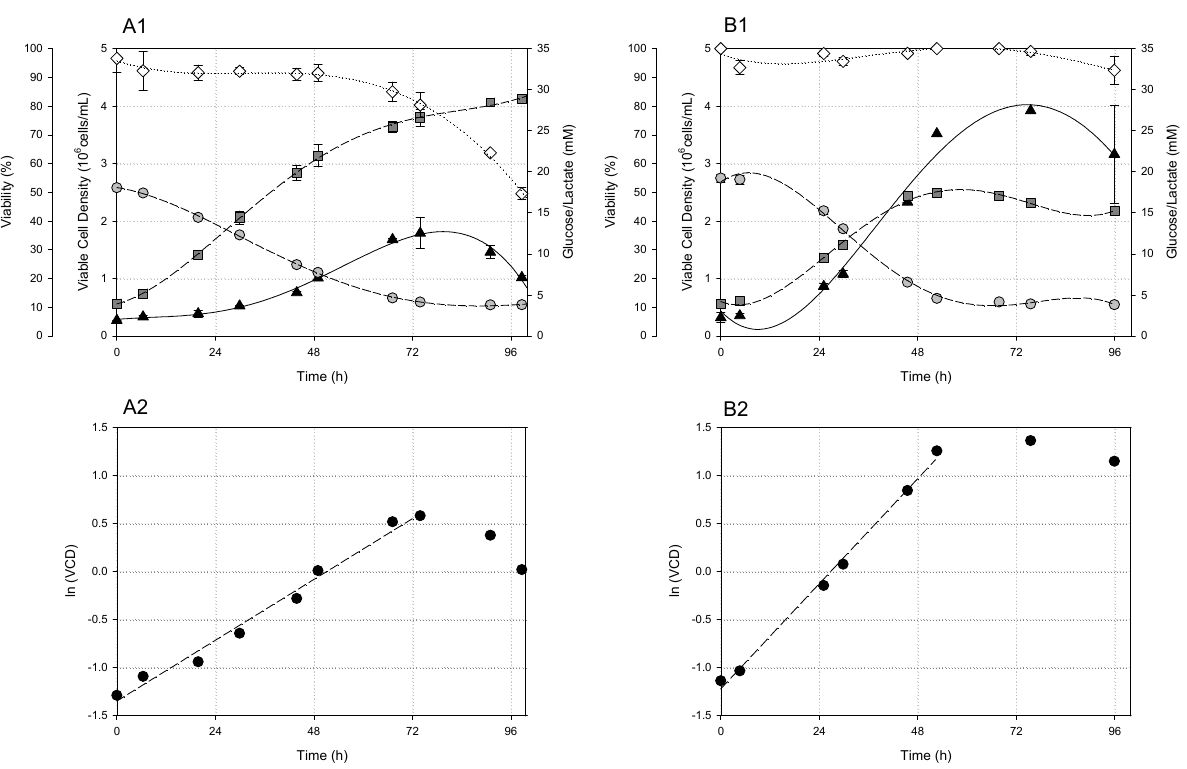
Figure 2. Two L bioreactor batch cultures of the parental KB26.5 cell line (A.1 and A.2) and the engineered KB26.5-BHRF1 Figure 1. Time profile of viable cell density ( (cid:78) ), cell viability ( ♦ ), glucose ( Figure 1. Time profile of viable cell density ( ▲ ), cell viability (◊), glucose (● ) and lactate ( ) concentration of batch cultures (B1 and B2). Time profile of cell density ( ▲ ), cell viability (◊); glucose ( ● ) and lactate ( ) and product (bars) concentration Figure 1. Time profile of viable cell density ( ▲ ), cell viability ( ◊ ), glucose ( ● ) and lactate ( ) concentration of batch cultures of batch cultures. Duplicate cultures are shown for each cell line. run in shake flasks (( A1 ): parental KB26.5 and ( B1 ): engineered KB26.5-BHRF1). Napierian logarithm of viable cell density run in shake flasks (A1: parental KB26.5 and B1: engineered KB26.5-BHRF1). Napierian logarithm of viable cell density run in shake flasks (( A1 ): parental KB26.5 and ( B1 ): engineered KB26.5-BHRF1). Napierian logarithm of viable cell density versus time ( ● ) (A2: parental KB26.5 and B2: engineered KB26.5-BHRF1). Data obtained from duplicate cultures in shake versus time ( • ) (( A2 ): parental KB26.5 and ( B2 ): engineered KB26.5-BHRF1). Data obtained from duplicate cultures in shake versus time ( ● ) (( A2 ): parental KB26.5 and ( B2 ): engineered KB26.5-BHRF1). Data obtained from duplicate cultures in flasks; the error bar corresponds to the standard deviation. flasks; the error bar corresponds to the standard shake flasks; the error bar corresponds to the standard deviation.